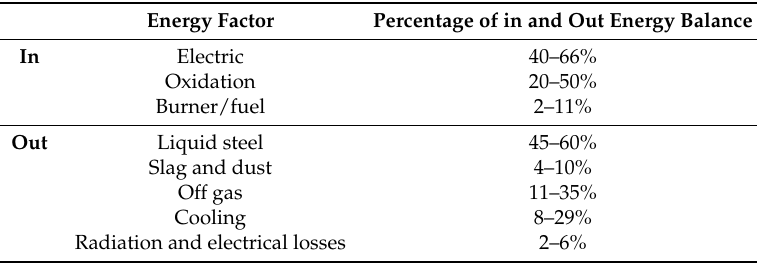
Table 2. Ingoing and outgoing energy in the EAF process as percentages of energy sources and energy sinks, respectively. Values are computed from